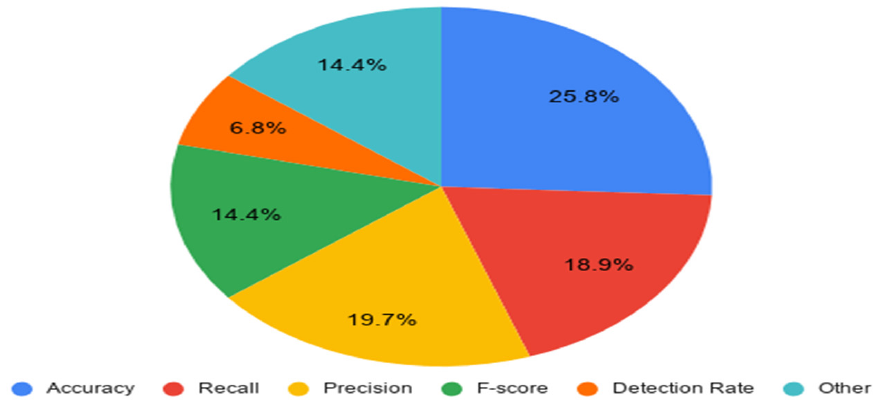
Figure 5. Evaluation metrics used in primary studies .